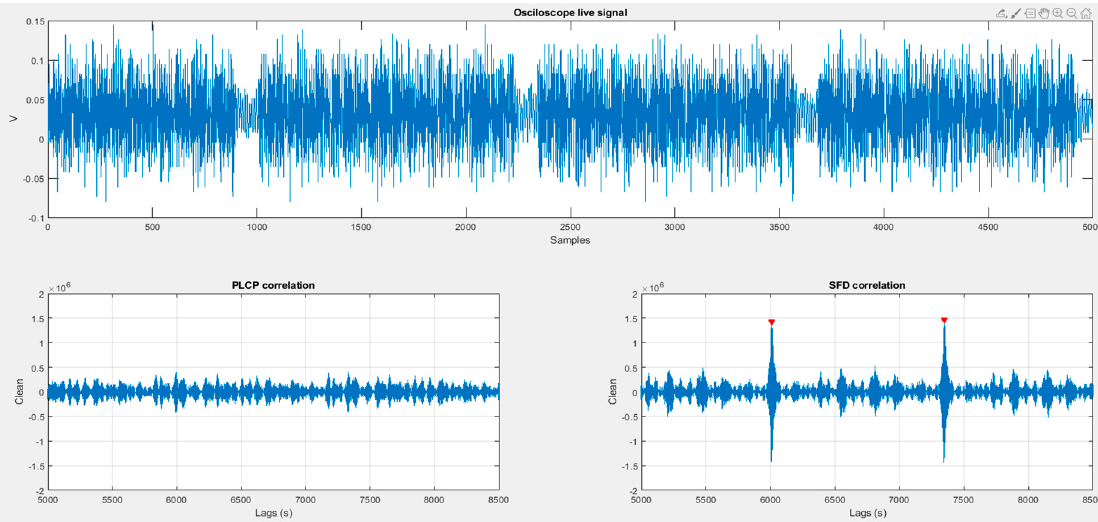
Figure 12 . HPC and HPW contact when SFD ID-code is being transmitted .